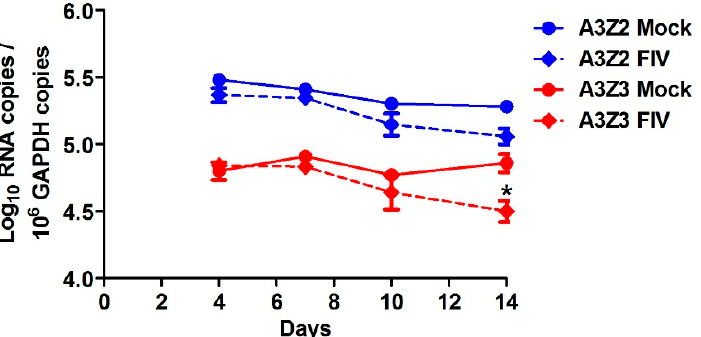
Figure 4. A3 expression in feline immunodeficiency virus (FIV)-infected cat PBMCs in vitro is relatively invariant from uninfected cells. PBMCs from three cats were infected with FIV at MOI 0.001 or mock infected. A3 expression was determined at days 4, 7, 10, and 14 post-infection. The only significant difference between infected and uninfected PBMCs was a reduced level of A3Z3 expression in FIV-infected cells at day 14 (*, p < 0.05). There was no difference in A3Z2-Z3 expression between infected and uninfected cells. Error bars represent standard errors of the means.